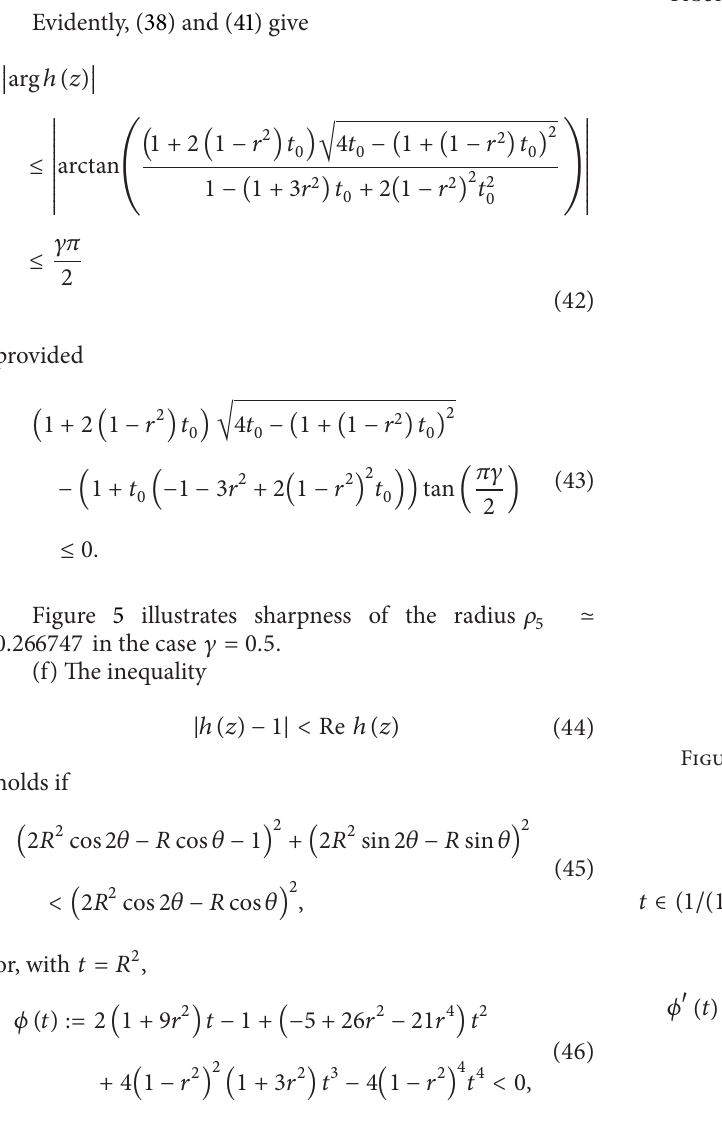
Figure 4: Image of |𝑧| ≤ (4 − √13)/3 touches |𝑤 − 1| = 0.5 .